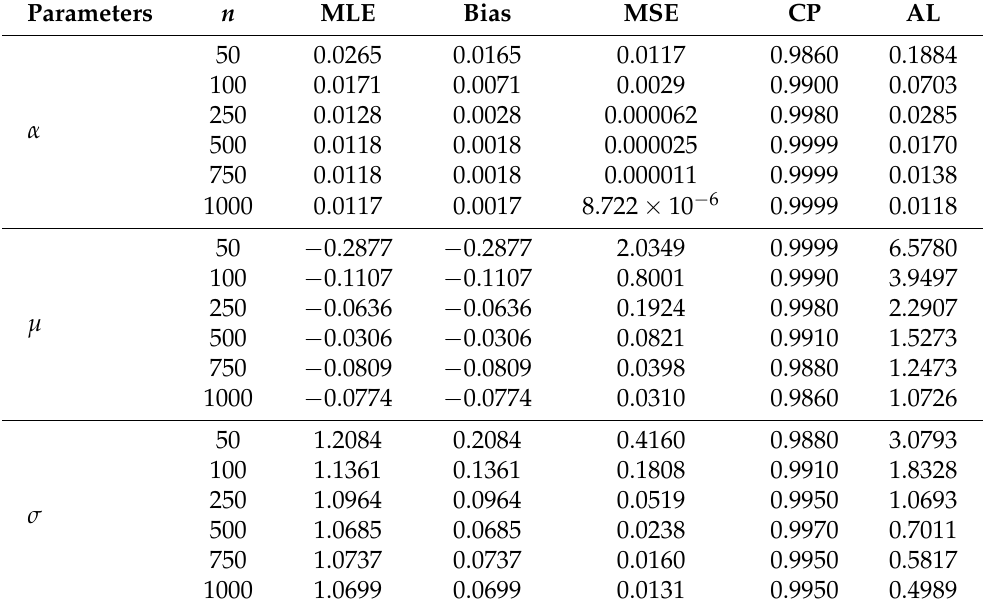
Table 1. The MLE simulation results for ( α = 0.01, µ = 0, σ = 1).